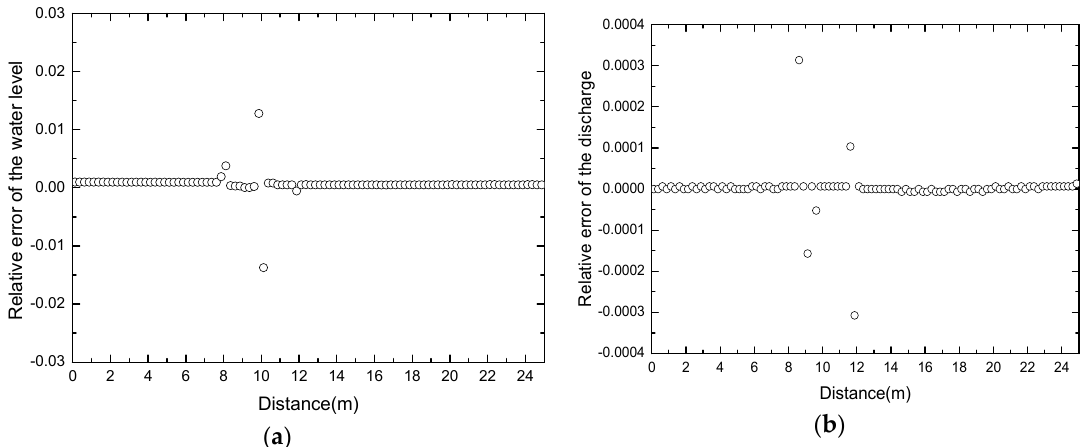
Figure 7. Transcritical flow without a shock over a bump. The relative error: ( a ) the water level z; ( b ) the discharge q = hu .